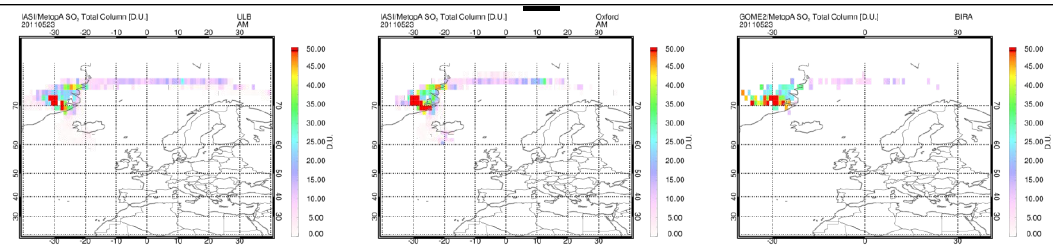
Figure 1: Estimated total atmospheric SO 2 load over Europe on May 23rd 2011 as seen by the ULB/IASI algorithm [left], the Oxford/IASI algorithm [middle] and the BIRA­IASB/GOME­2 algorithm [right].